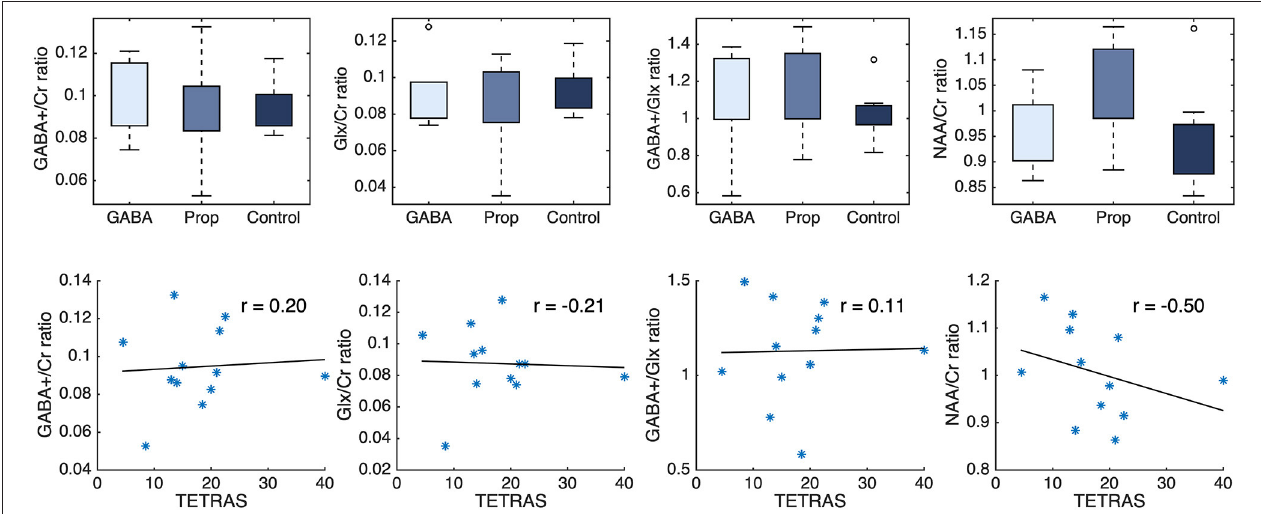
FIGURE 2 | (Upper) GABA + /Cr, Glx/Cr, GABA + /Glx, and NAA/Cr ratios show no difference between ET patients using GABAergic-medication (GABA) or propranolol medication (Prop), and healthy controls (Control). (Lower) TETRAS-scores (OFF-medication) of ET patients are not correlated with GABA + s/Cr, Glx/Cr, GABA + /Glx, and NAA/Cr ratios. *represent individual ET patients. Cr, creatine; ET, Essential Tremor; Glx, glutamate plus